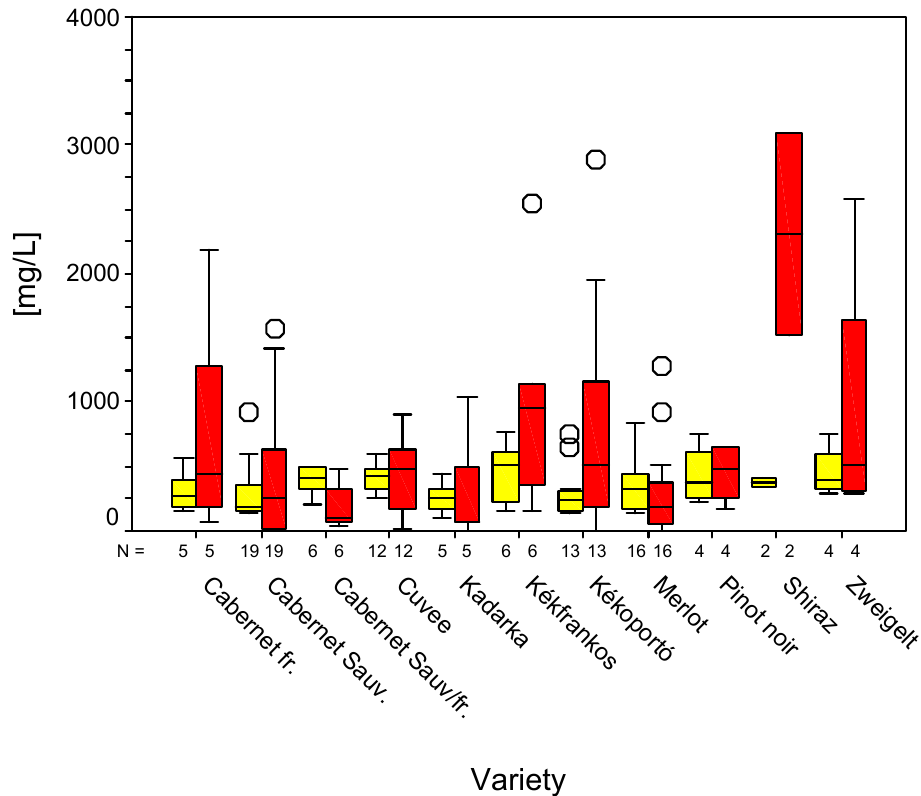
Figure 1. Polyphenol (yellow) and anthocyanin (red) content of red wines (n=92) from the Hungarian “Villány”